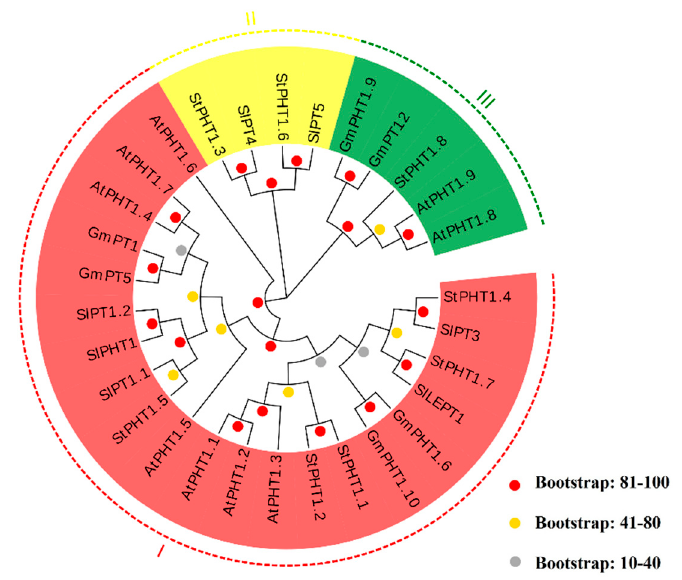
Figure 3. The phylogenetic tree of PHT1 proteins of potato, tomato, Arabidopsis , and soybean. The phylogenetic tree was constructed using the neighbor-joining method with 1000 bootstrap replications. PHT1 genes were distributed in three main groups, including I, II, and III, which were marked with different colors. PHT1 families are indicated with different colors. Prefx “St” indicates Solanum tuberosum (potato), “Gm” indicates Glycine max (soybean), “At” indicates Arabidopsis thaliana , and “Sl” indicates Solanum lycopersicum (tomato). At the nodes, red dots represent bootstrap values that were between 81 and 100; yellow dots show the bootstrap values that were between 41 and 80; and gray dots indicate that the bootstrap values were less than or equal to 40.